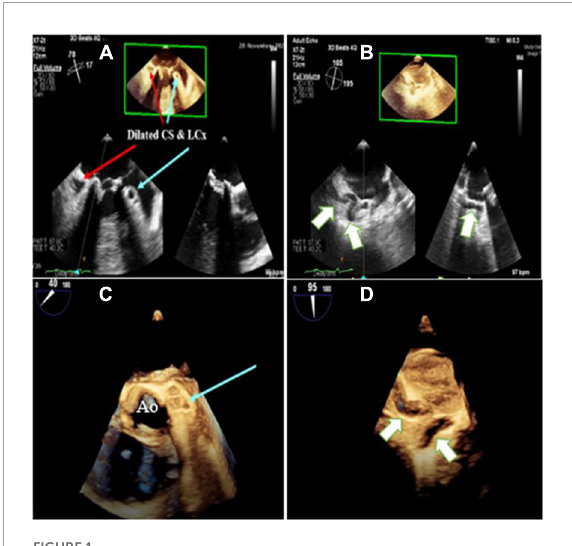
FIGURE3 Contrast-enhanced CT scan of the chest, as well as CCTA, show the proximal site of a giant fistula originating from the left circumflex artery (white arrow), draining into the coronary sinus and forming a pouch (blue arrow). Reconstruction of coronaries illustrates a giant fistula (red color